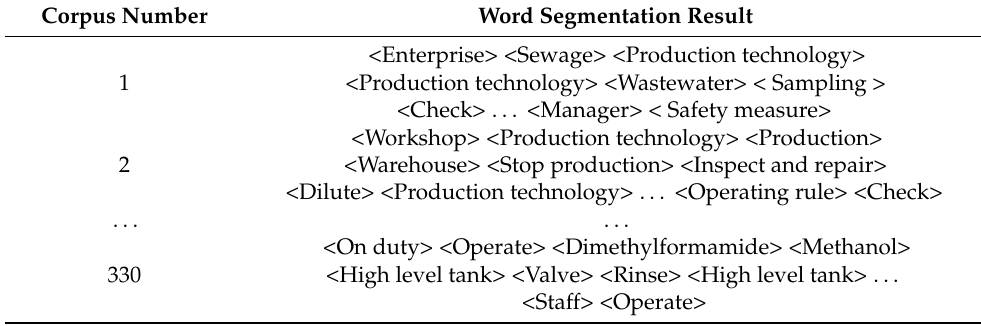
Table 2. Partial splitting